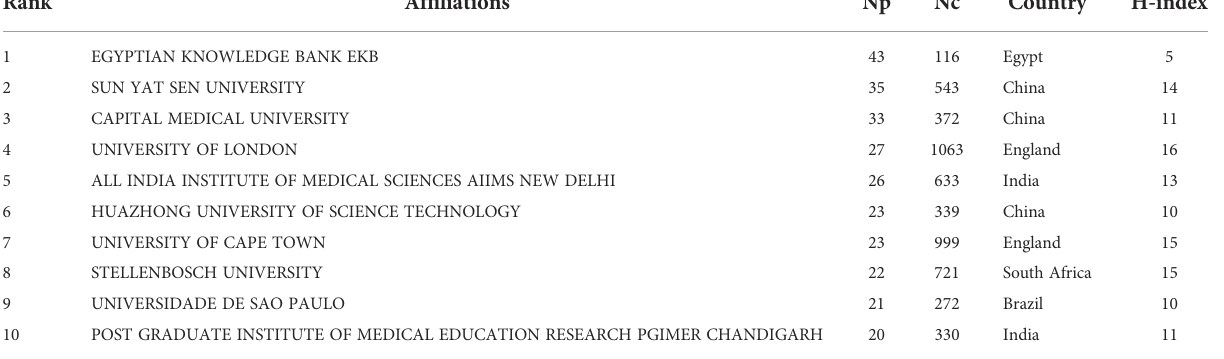
TABLE 2 The 10 most productive af fi liations.